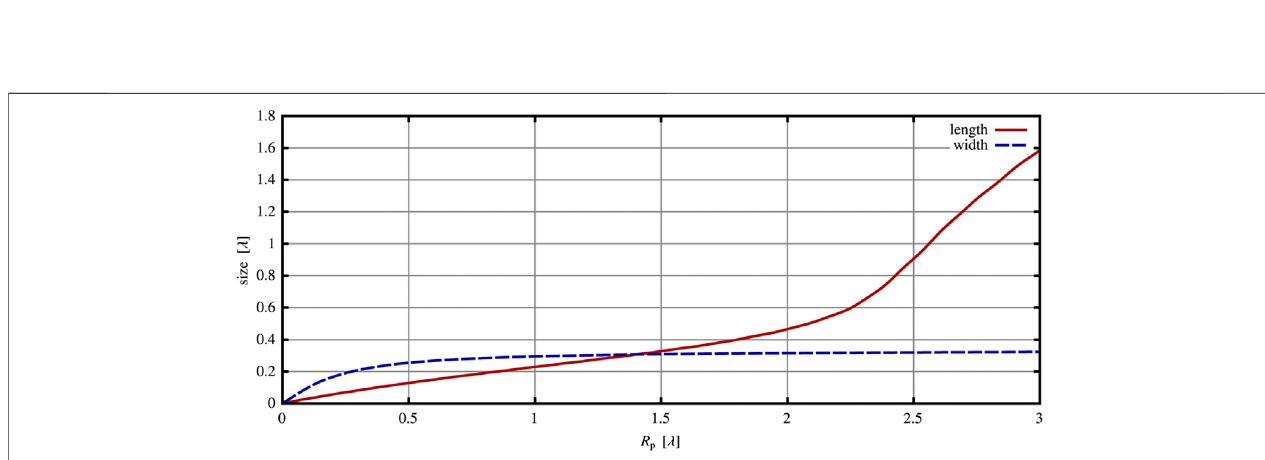
FIGURE7| Dependence ofthelengthandwidthoftheplasmonicnanojet/hotspotonaparticlesize.TheincidentwaveisaradialGaussianbeam(LG 0,rad ). ϵ p / ϵ med (cid:2) − 22.5 + 1.4 i , f (cid:2) 0.3, and z (cid:2) 0.75 R b p .